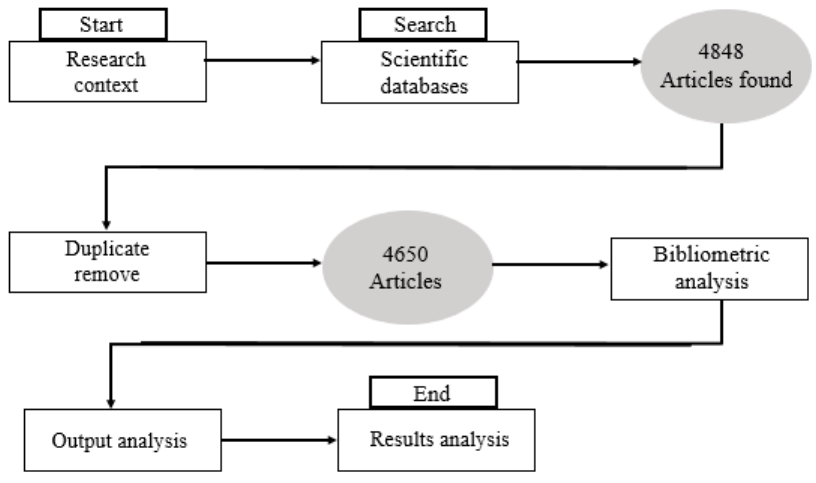
Figure 1. Bibliometric analysis steps .